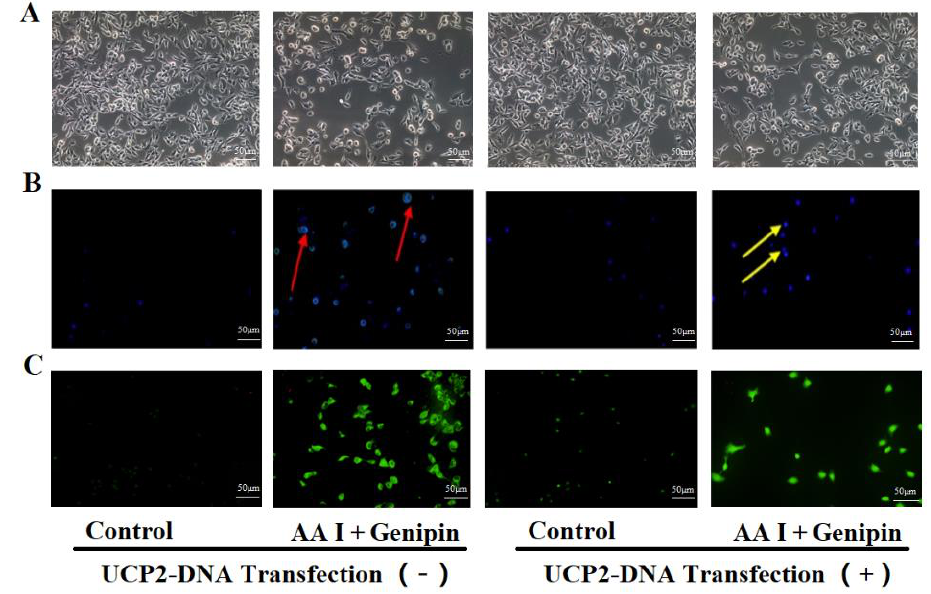
Figure 6. Increasing UCP2 expression alleviated the cytotoxicity of AA I to HK-2 cells. ( A ) Inverted phase contrast microscope was used to observed the morphology of transfected or non-transfected cells after cells were treated with AA I and genipin (scale bar, 50 µM). ( B ) The nuclear morphology of transfected or non-transfected cells was evaluated using Hoechst 33,258 staining by fluorescence microscope (scale bar, 50 µM). The yellow arrows indicate the chromatin condensation, which is brightly stained and the red arrows show DNA fragmentation. ( C ) The intracellular ROS was measured using fluorescence microscopy (scale bar, 50 µM) with probe DCFH-DA.